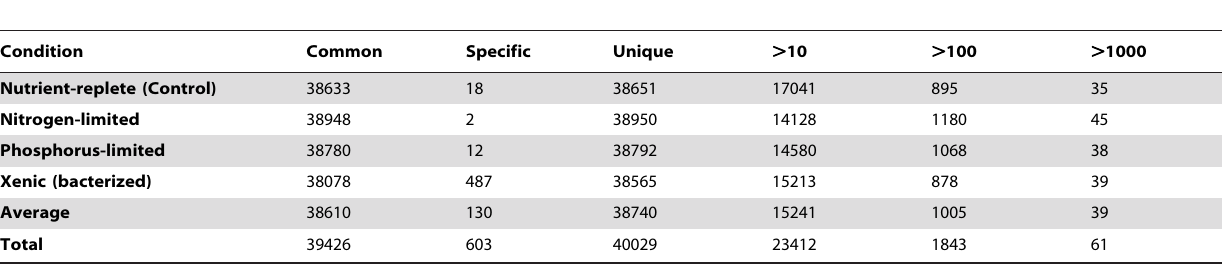
Table 1. Summary of Alexandrium tamarense MPSS signatures that were significant and reliable.